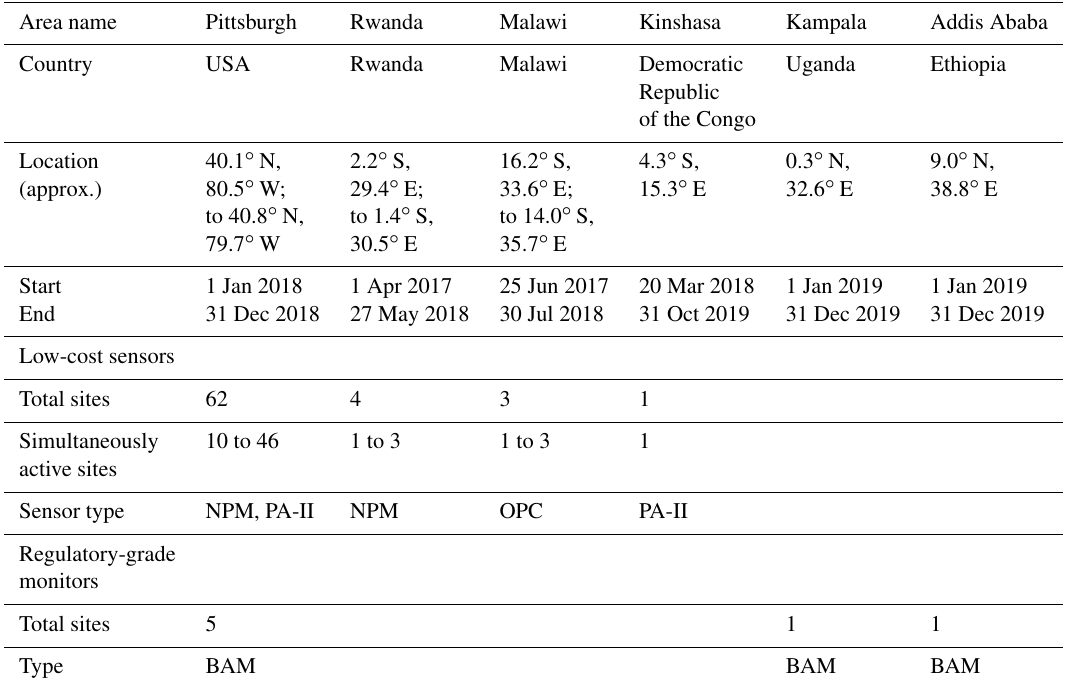
Table 2. Summary information for the ground sites presented in this paper. Area